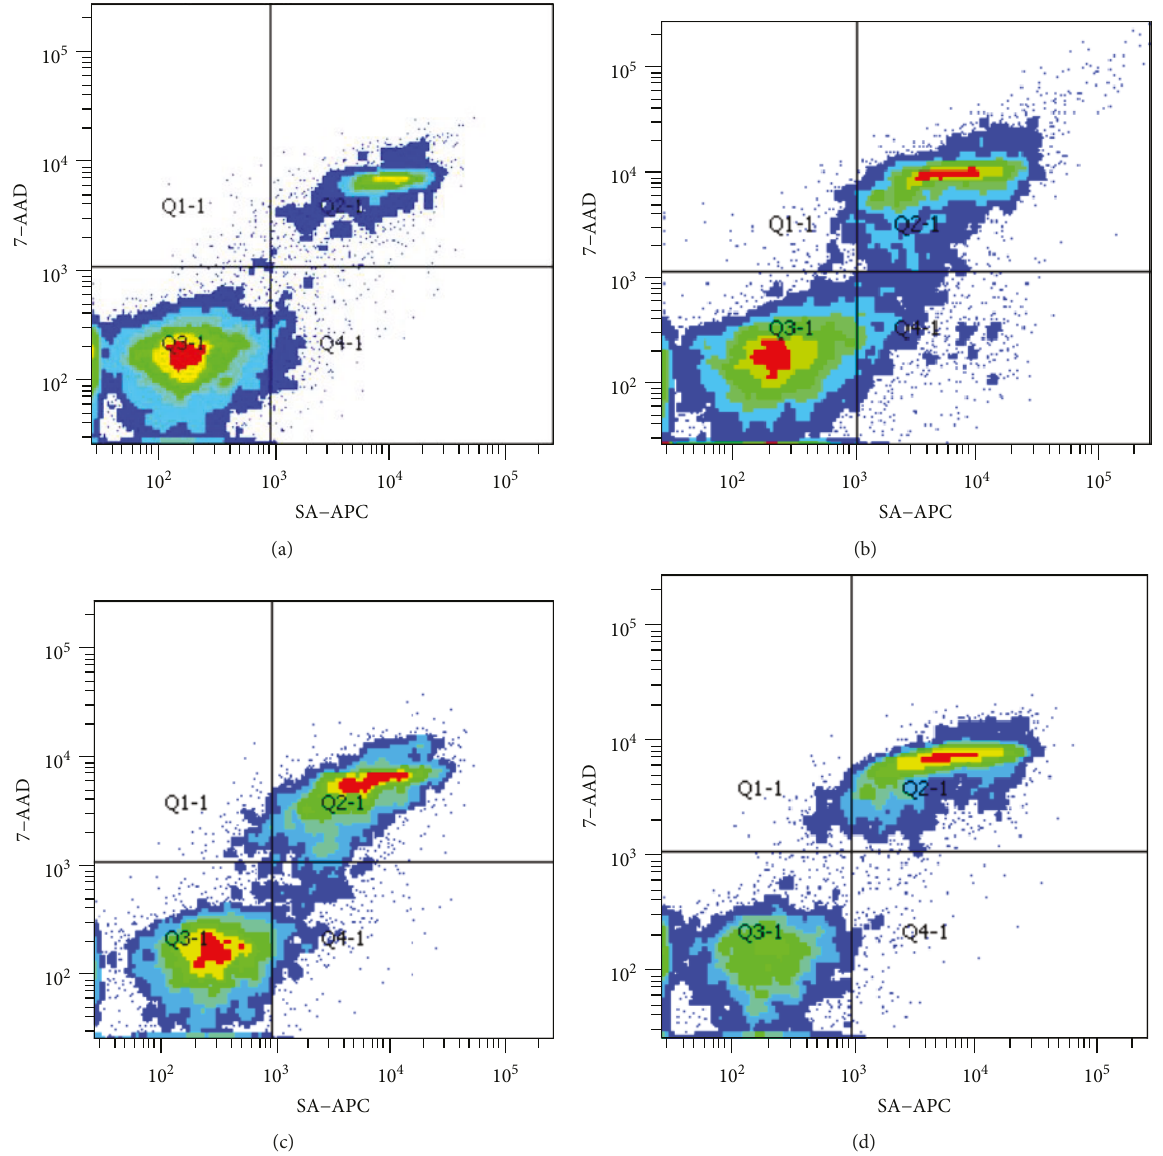
Figure 2: E ff ects of LPS doses on human pulmonary artery endothelial cell apoptosis. (a) Negative control (LPS 0ng/mL); the rate of apoptosis of cells without LPS stimulating. (b) The rate of apoptosis of cells with LPS stimulating in 100ng/mL. (c) The rate of apoptosis of cells with LPS stimulating in 500 ng/mL. (d) The rate of apoptosis of cells with LPS stimulating in 1 μ